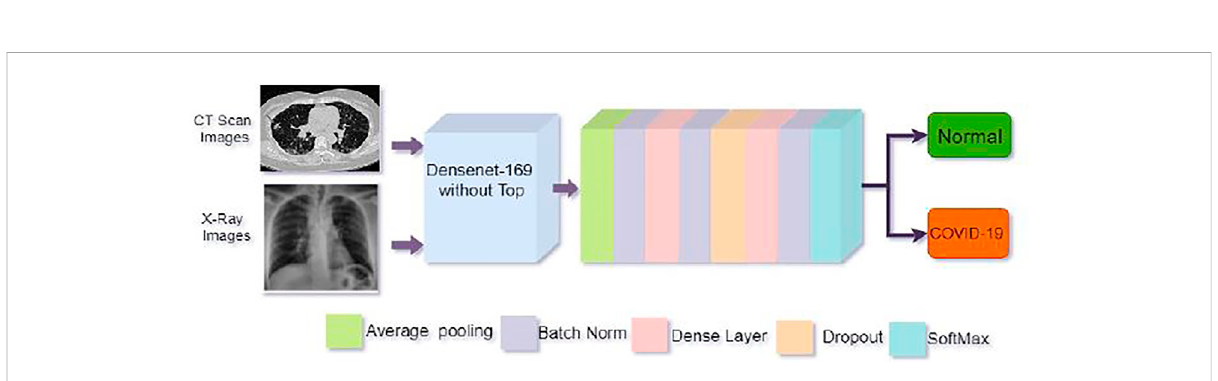
FIGURE 4 Architectureoftheproposedmodel.Thetopofthepre-trainedDenseNet169modelwasremovedandthenaddedsomelayersasshowninthe fi gure for better COVID-19